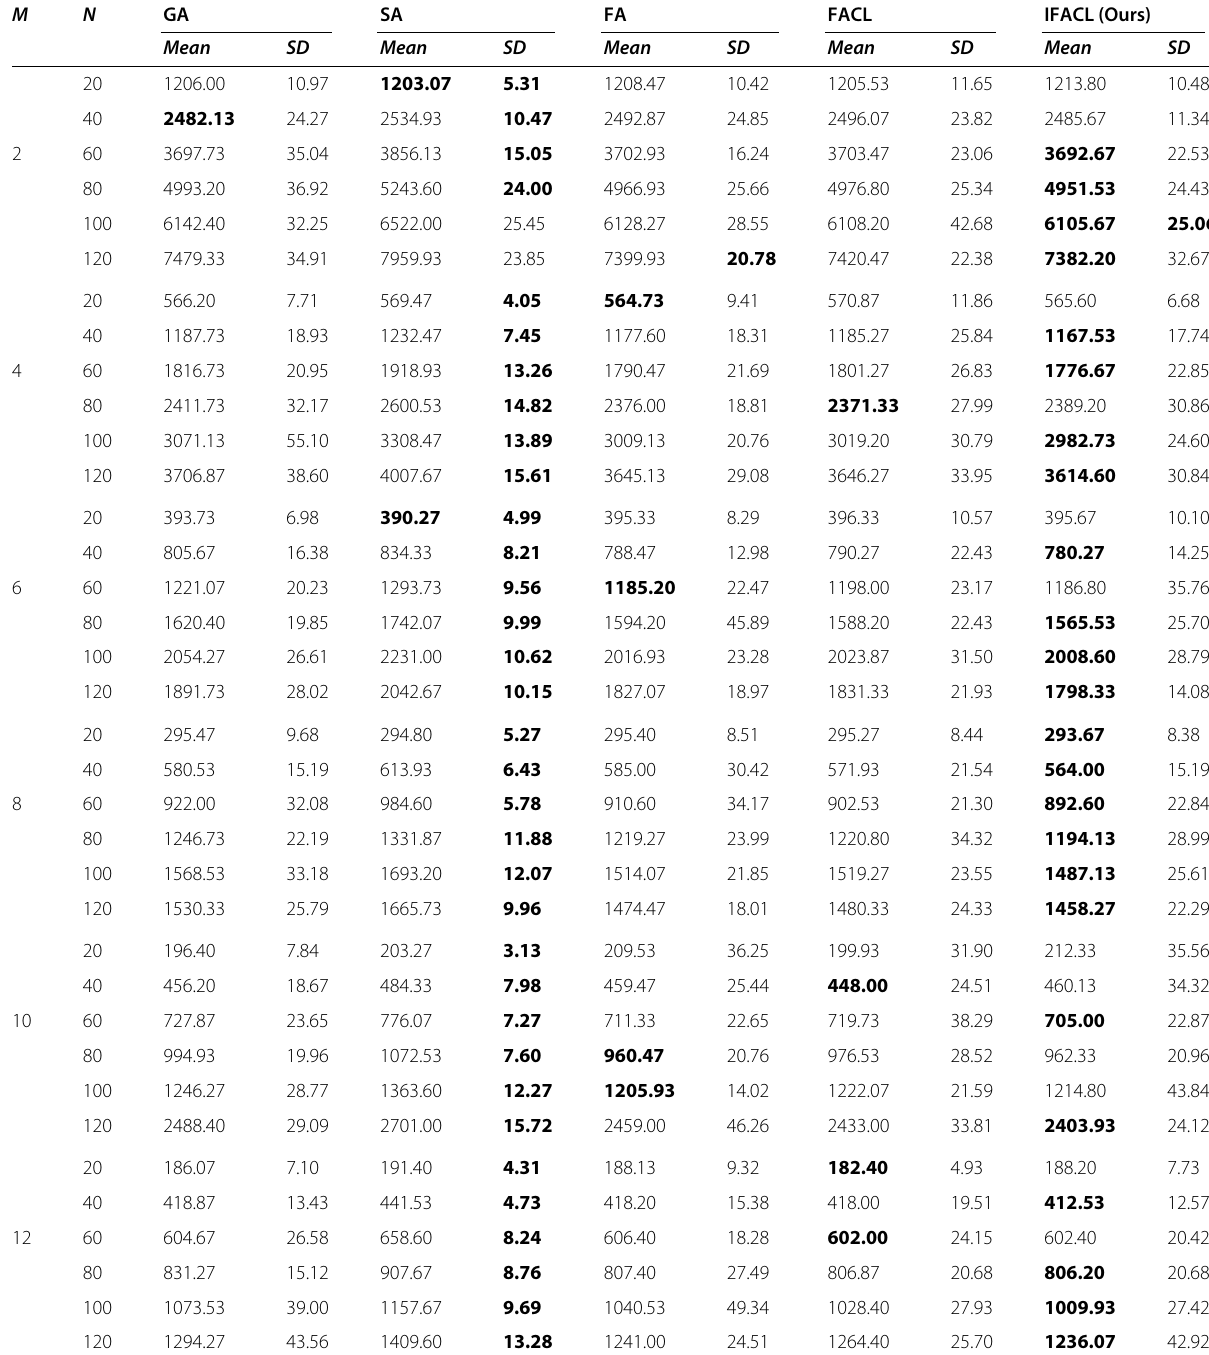
Table 6 Comparison between IFACL algorithm and four comparison algorithms in P , SBalanced instances on